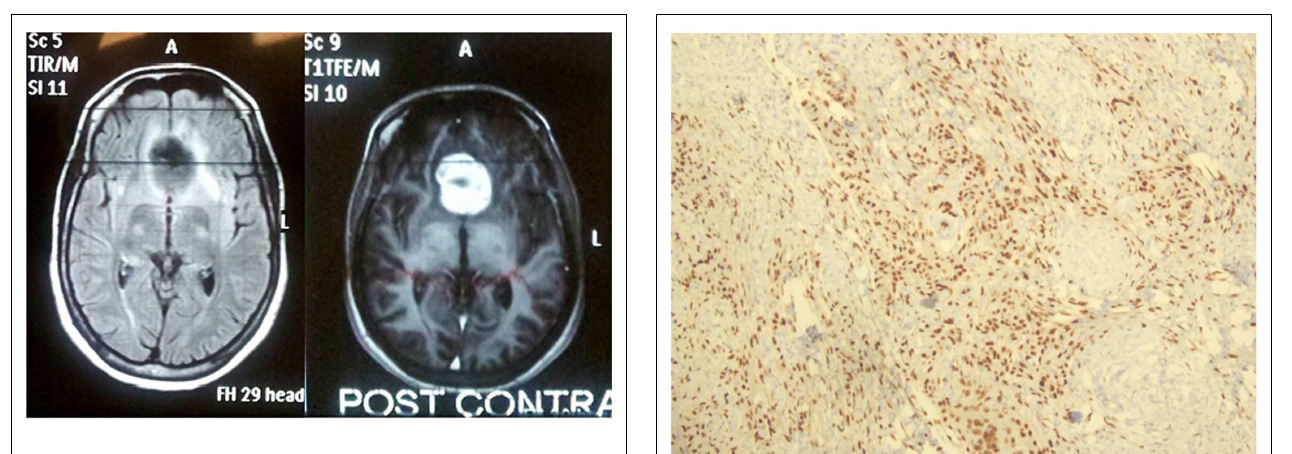
FIGURE 1 | MRI of the brain with and without contrast done in Rwanda 1year previous to admission to our institution showed